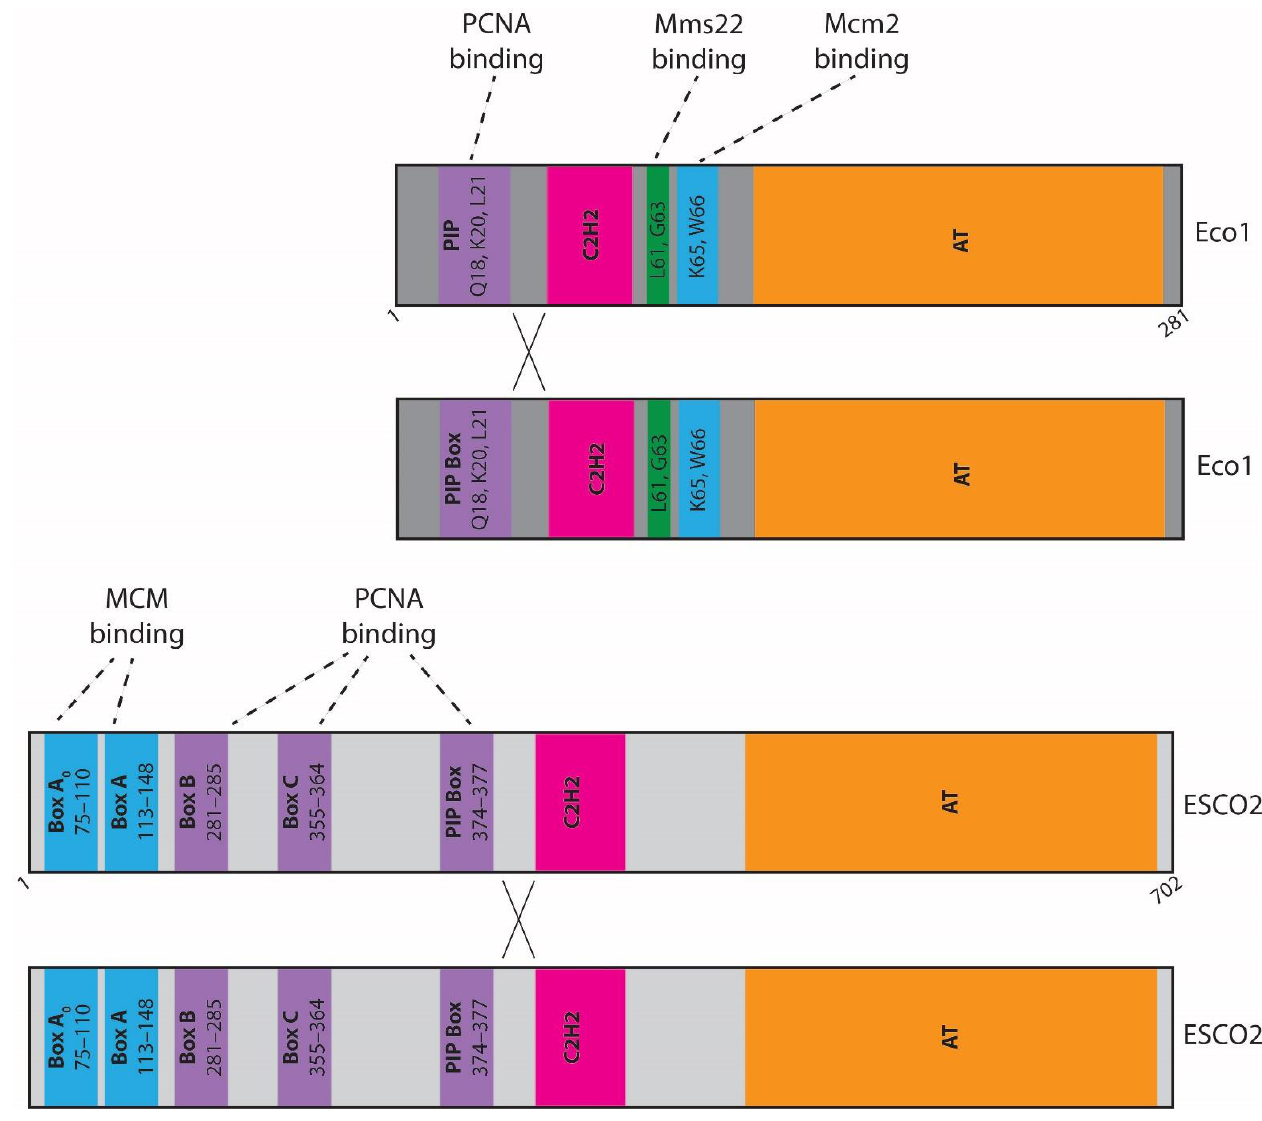
Figure 1. Eco1/ESCO2 interact with replication factors. Schematic domain maps of yeast Eco1 ( above ) and Xenopus ESCO2 ( below ). C 2 H 2 indicates the zinc finger motif and AT indicates the acetyltransferase domain. Within Eco1, PCNA binds to amino acids Q18, K20, and L21; Mms22 binds to amino acids L61 and G63; and Mcm2 binds to amino acids K65 and W66. Within ESCO2, MCM binds Box A 0 and Box A, and PCNA binds to Box B, Box C, and the PIP box. Additional evidence suggests dimerization of Eco1/ESCO2 is important for its function, indicated by the “X.”.